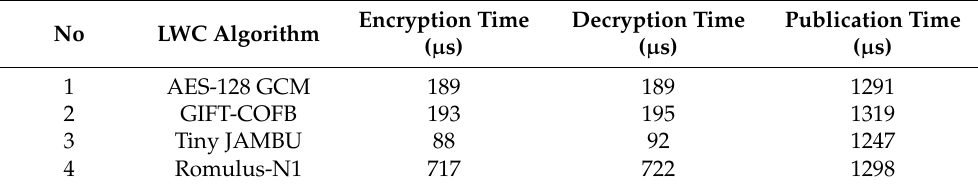
Table 14. Lightweight Cryptographic Encryption and Decryption Performance on STM32L4 with 20 Characters Messages Used Registered